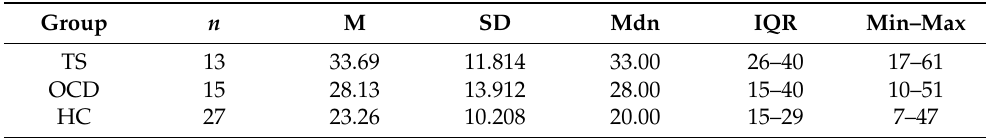
Table A5. Scores in the German short version of the Wender Utah Rating Scale (WURS-K) in